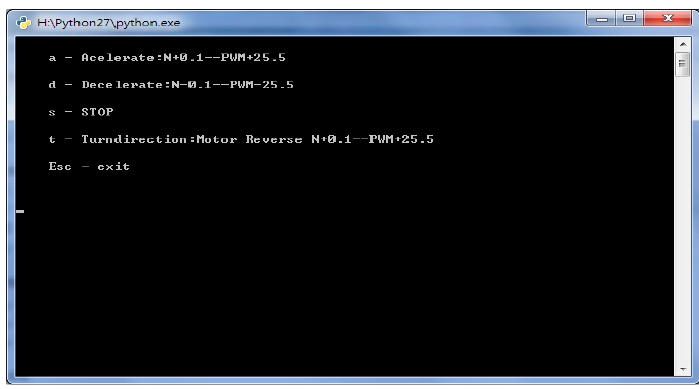
Figure 7. Input interface window.